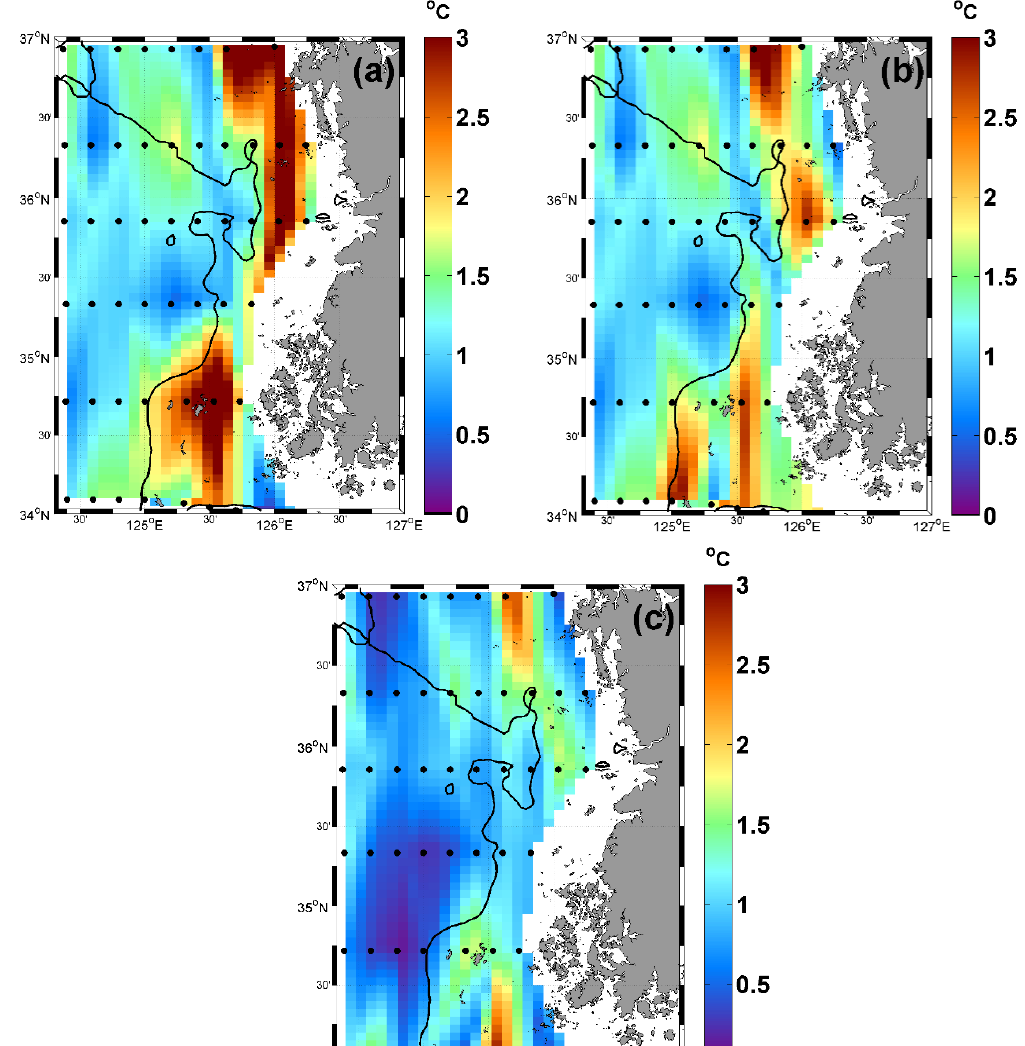
Figure 9. Spatial distribution of the RMSDs (°C) between ( a ) the original OSTIA SST, ( b ) the OSTIAabc SST, and ( c ) the OSTIArbc SST compared with the in situ CTD SST for June from 2010 to 2013. The black contour represents the 50-m isobaths in the Eastern YS.